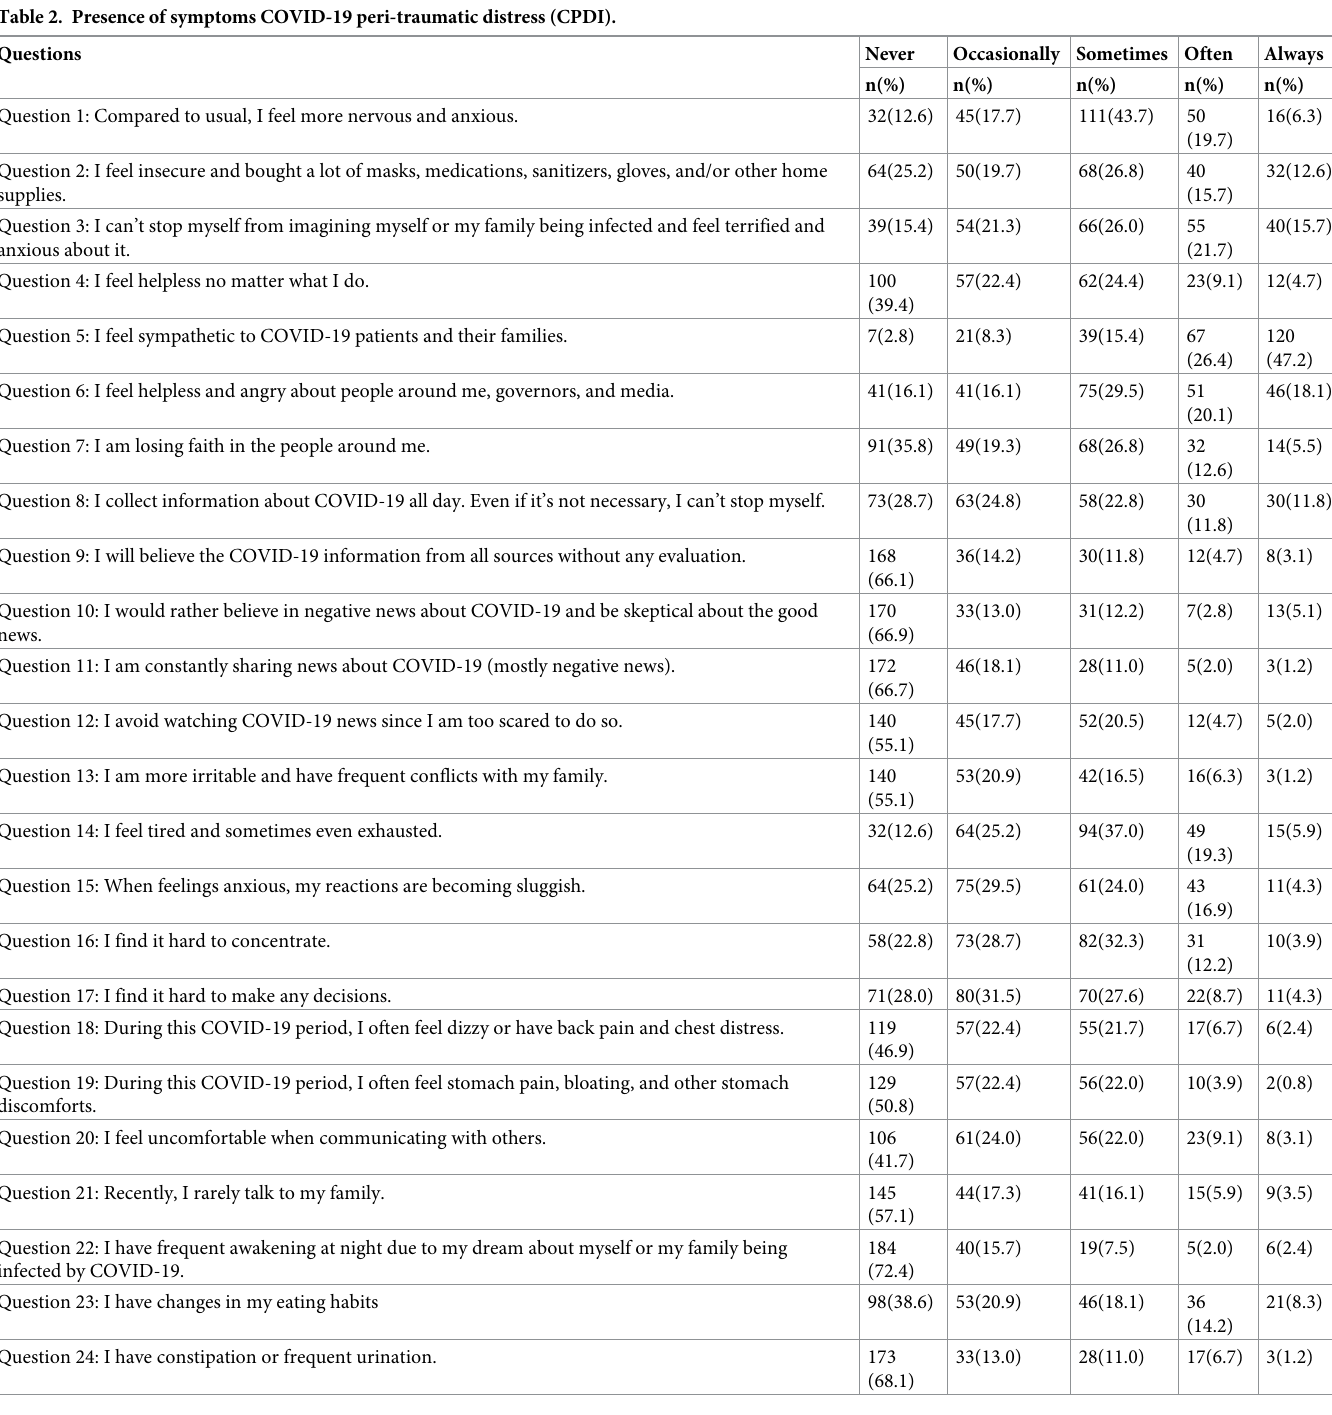
Table 2. Presence of symptoms COVID-19 peri-traumatic distress